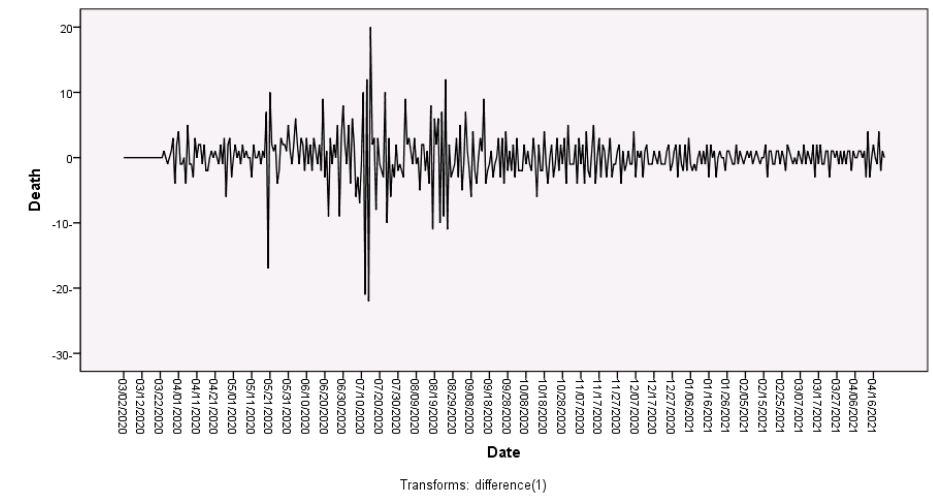
Figure 6. Transmission of the death cases of COVID-19 in Saudi Arabia to the first difference.